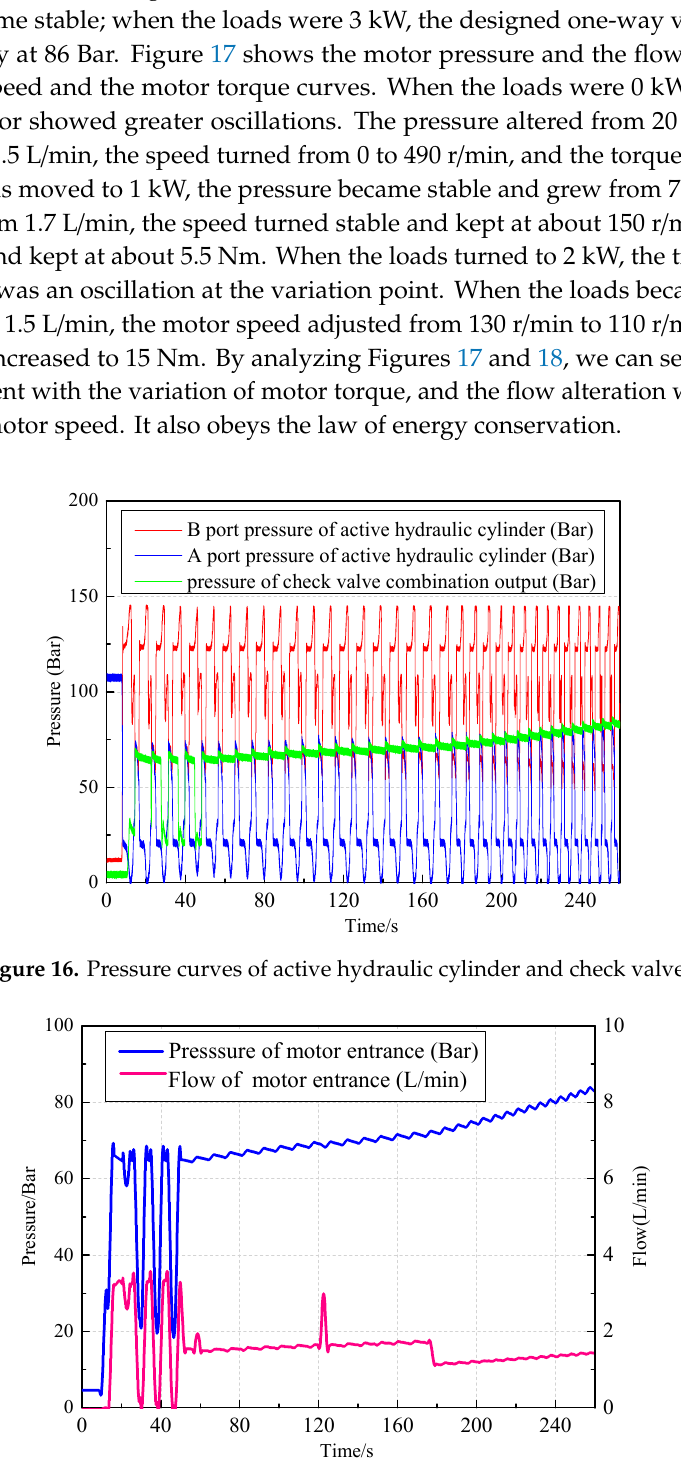
Figure 17. Motor pressure and flow curves.